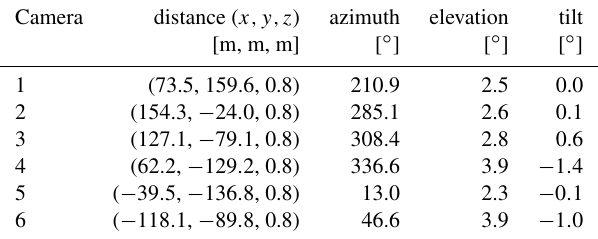
Table A1. Camera pose and position.